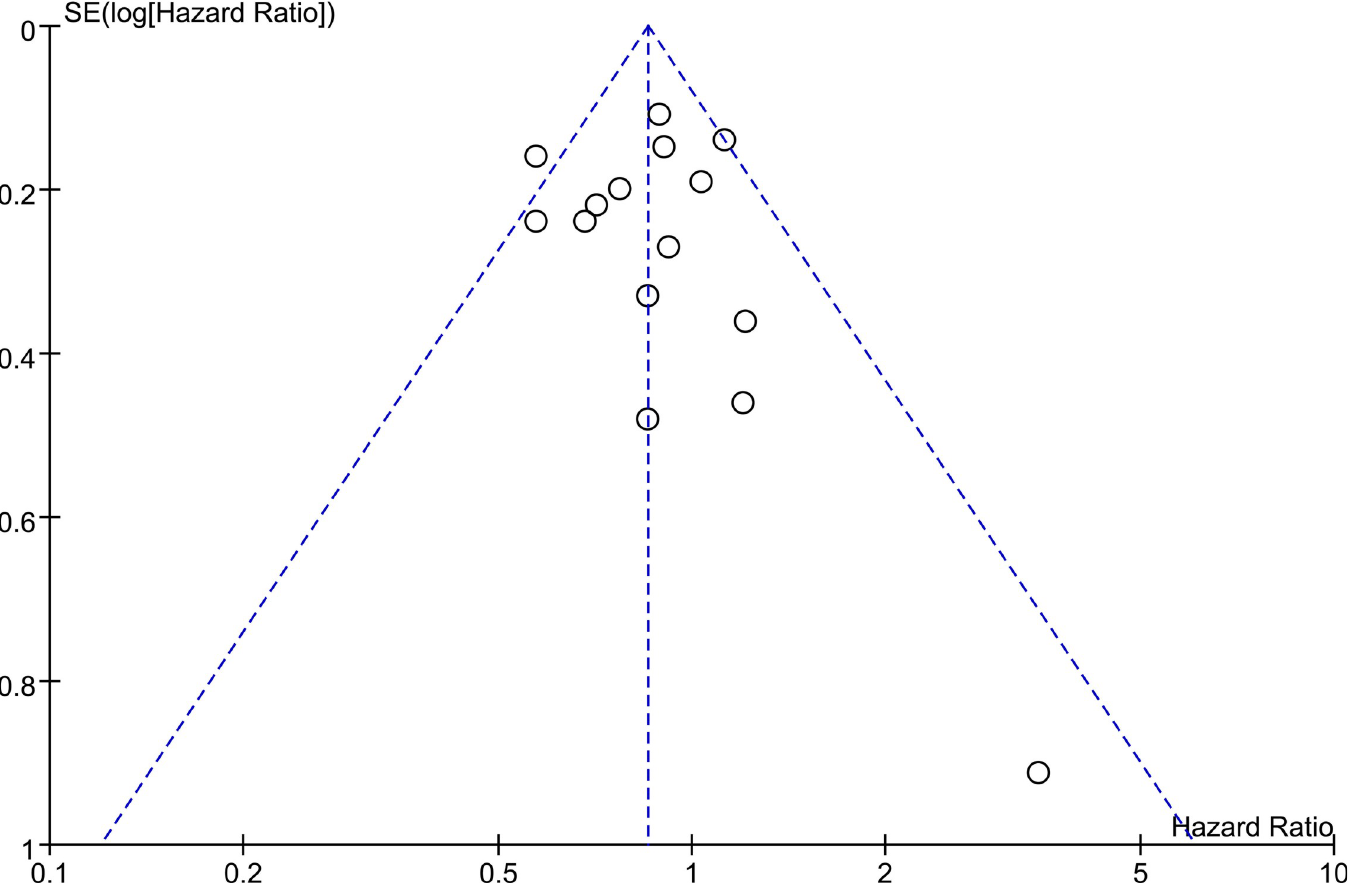
Fig 3. Funnel plot analysis of overall survival.